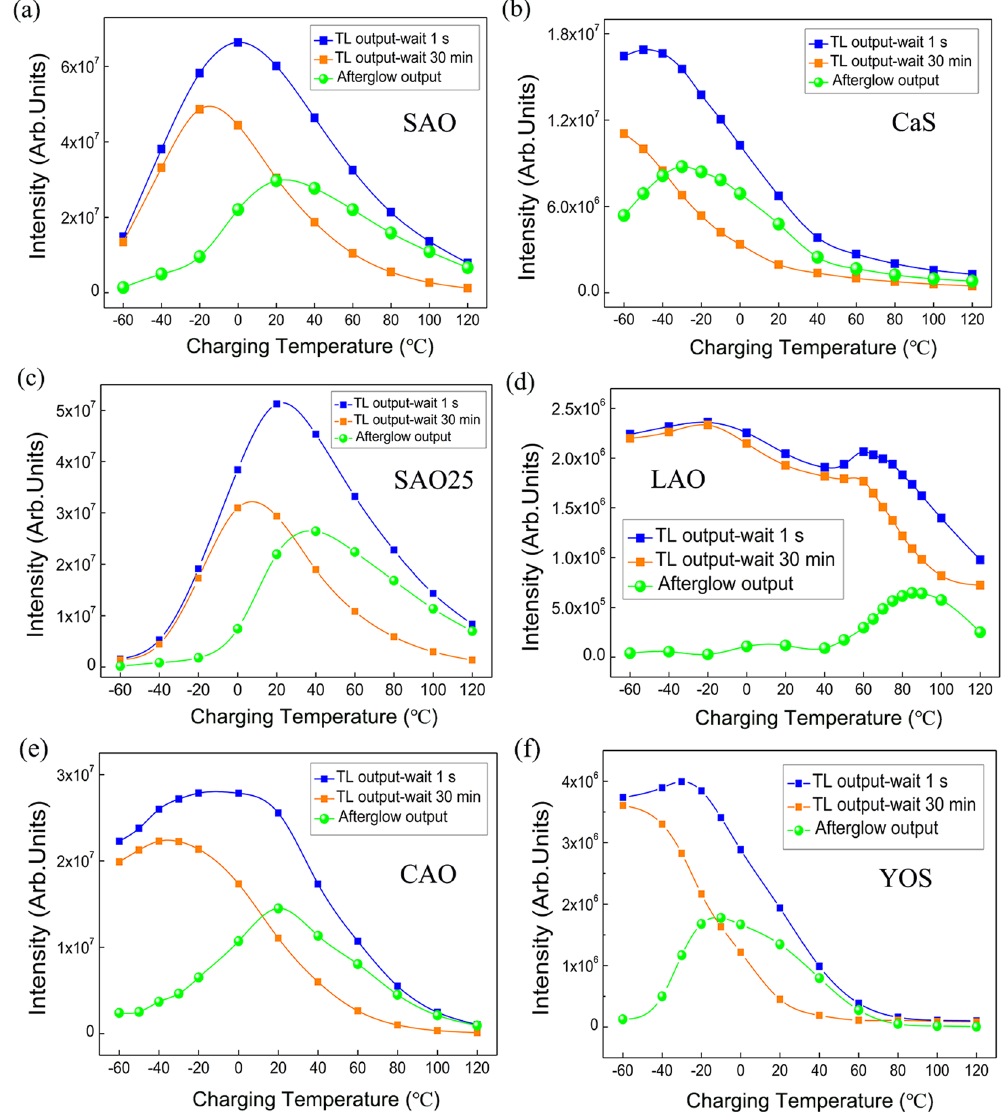
Figure 5. Blue curves: Integrated light emission during the TL measurement (with 1 sec fading) after charging 10 min at different temperatures, i.e., a measure for the total accumulated light emission from the phosphor or the total amount of filled traps after excitation. Orange curves: Integrated light emission during the TL measurement (with 30 min fading) after charging 10 min at different temperatures. Green curves: the extracted afterglow output from blue and orange curves at different temperatures. ( a ) SAO phosphor ( b ) CaS phosphor ( c ) SAO25 phosphor ( d ) LAO phosphor ( e ) CAO phosphor ( f ) YOS